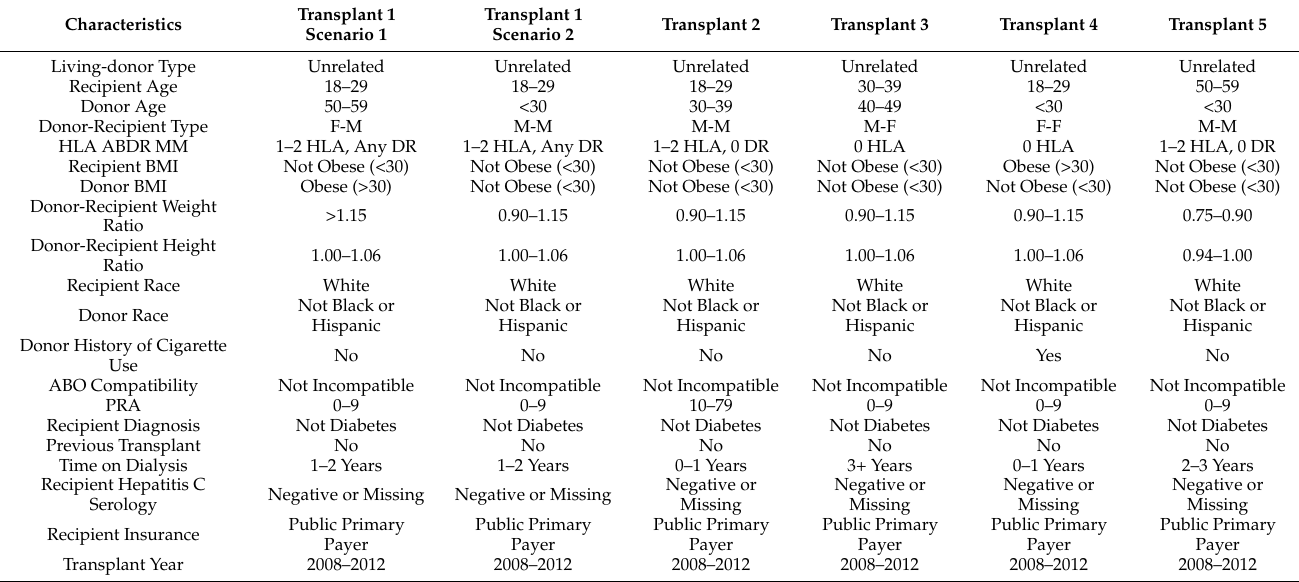
Table 2. Characteristics of transplants in the chain in scenarios 1 & 2. HLA, human leukocyte antigen. MM, mismatch. BMI, body mass index. PRA, panel reactive antibody.